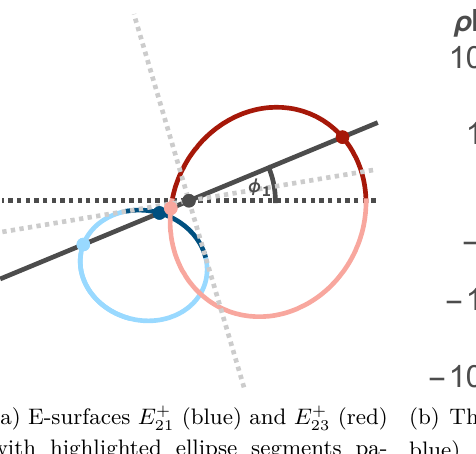
(a) E-surfaces E + with highlighted ellipse segments pa- rameterised by r + (light), respectively.